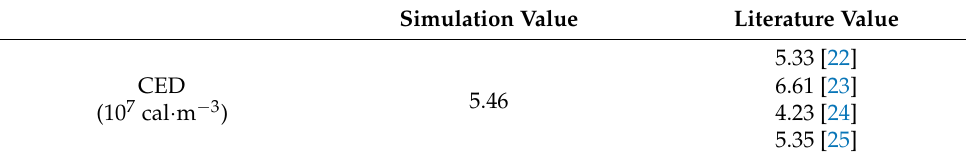
Table 1. CED values of